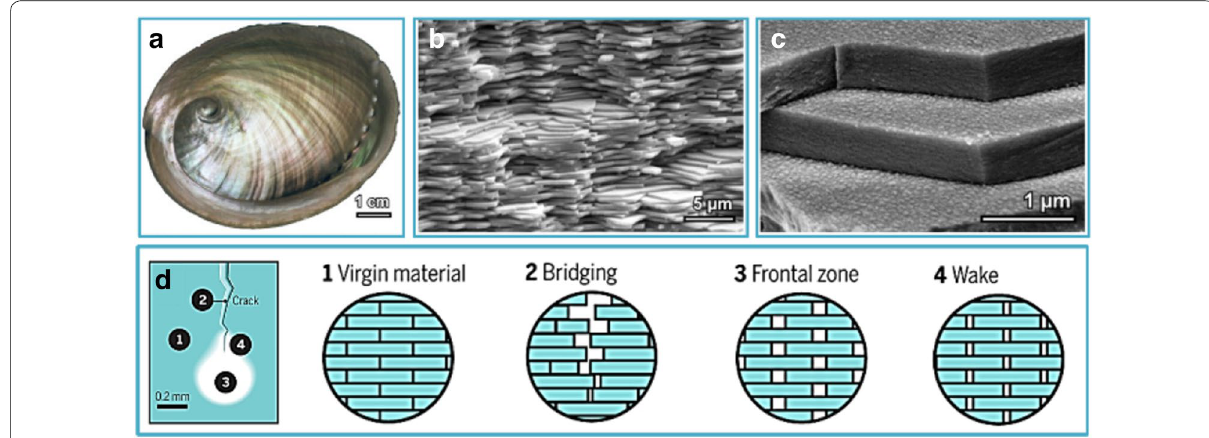
Figure 6 ( a ) The inner iridescent region of a gastropod ( Haliotis laevigata ) [21]; ( b ) The fractured cross section of the nacreous layer obtained by scanning electron microscopy (SEM) [21]; ( c ) A close-up view on the platelets obtained by high-magnification SEM [21]; ( d ) Schematic diagram of the fracture resistance of brick and mortar structure